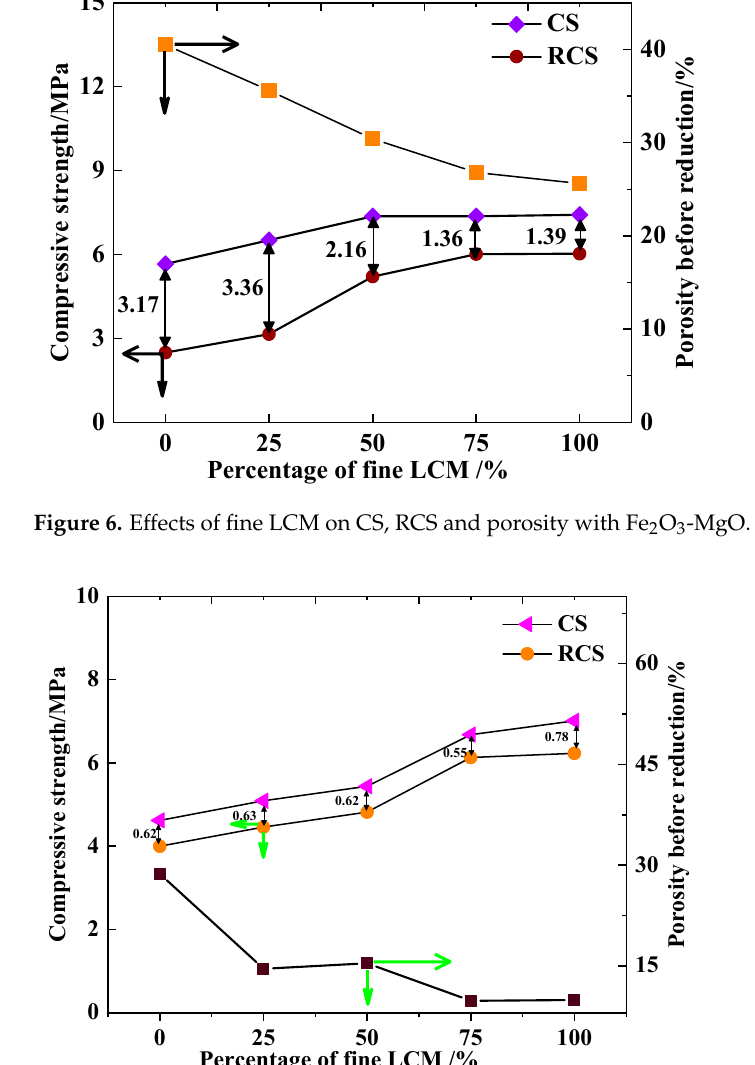
Figure 7. Effects of fine LCM on CS, RCS and porosity of Fe 2 O 3 -MgO- CaO.